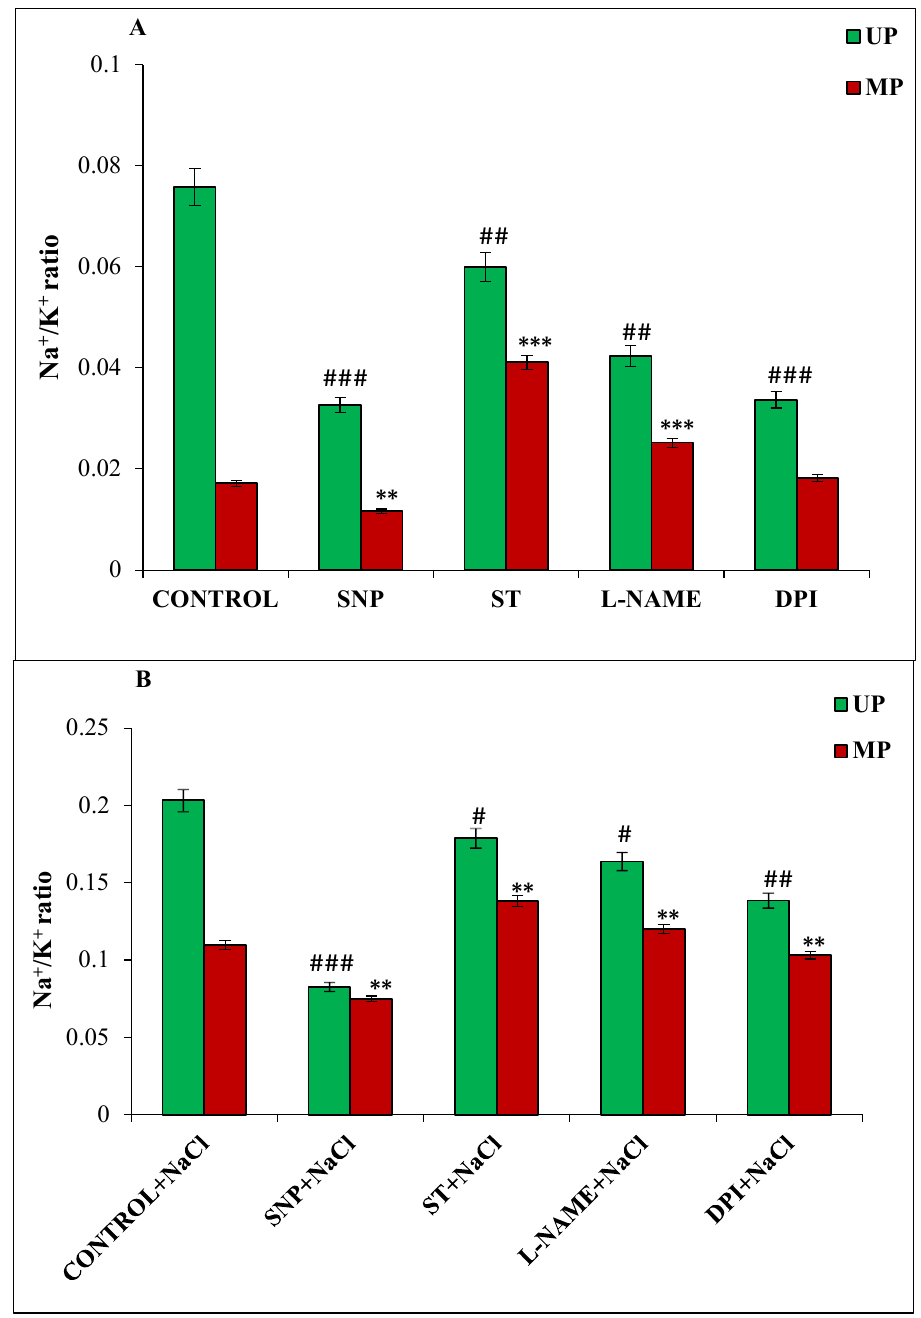
Figure 2. Effect of magnetopriming (200 mT SMF for 1 h) on Na + /K + ratio in 72 h germinated soybean seeds in different modulators of NO and ROS production under non-saline ( A ) and saline ( B ) conditions. The data are represented as means ±SE (n = 3). # ## p < 0.001, ## p < 0.01, # p < 0.05 indicates the significant difference amongst the UP seeds grown in control with the UP seeds grown in different modulators of NO/ROS production under non-saline or saline conditions; *** p < 0.001, ** p < 0.01 indicates the significant difference amongst the seeds of MP seeds grown in control with the seeds of magnetoprimed seeds grown in different modulators of NO/ROS production under non-saline or saline conditions.